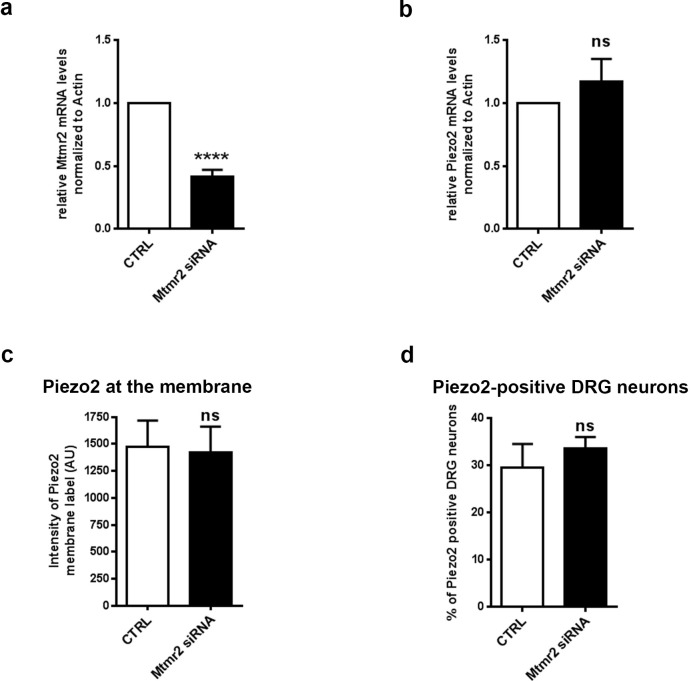
Mtmr2 knockdown in cultured DRG neither affects Piezo2 mRNA nor Piezo2 membrane levels or overall expression.(a) Quantification of Mtmr2 mRNA upon siRNA transfection in DRG neurons showed a significant decrease in Mtmr2 mRNA (Actin as reference: 0.42 ± 0.05; p<0.0001; one sample t-test; N = 8 independent DRG cultures). Of note, our qPCR results indicate successful siRNA-mediated knockdown of Mtmr2 across the whole coverslip, which also includes non-transfected neurons and glia cells. Therefore our data do not report on the transfection efficiency and extent of Mtmr2 knockdown in individual neurons. (b) Quantification of Piezo2 mRNA upon Mtmr2 knockdown in DRG neurons confirmed that Piezo2 mRNA levels are similar to controls (Actin (Actb) as reference: 1.17 ± 0.18; ns; one sample t-test; N = 8 independent DRG cultures). (c) Quantification of Piezo2 membrane expression in DRG cultures derived from Piezo2GFP mice (Woo et al., 2014) upon Mtmr2 knockdown. No difference was observed among conditions (CTRL: 1470 ± 246.7 AU; Mtmr2 siRNA: 1424 ± 237.5 AU; n = 22 neurons per condition from N = 2 independent DRG cultures; ns; Mann-Whitney test). AU, arbitrary units. (d) Percentage of Piezo2-positive cells in DRG cultures derived from Piezo2GFP mice treated with CTRL or Mtmr2 siRNA. No difference was observed among analyzed conditions (CTRL: 29.59 ± 4.97%; Mtmr2 siRNA: 33.59 ± 2.45%; ns; Mann-Whitney test; n > 1000 neurons per condition; N = 3 independent DRG cultures).